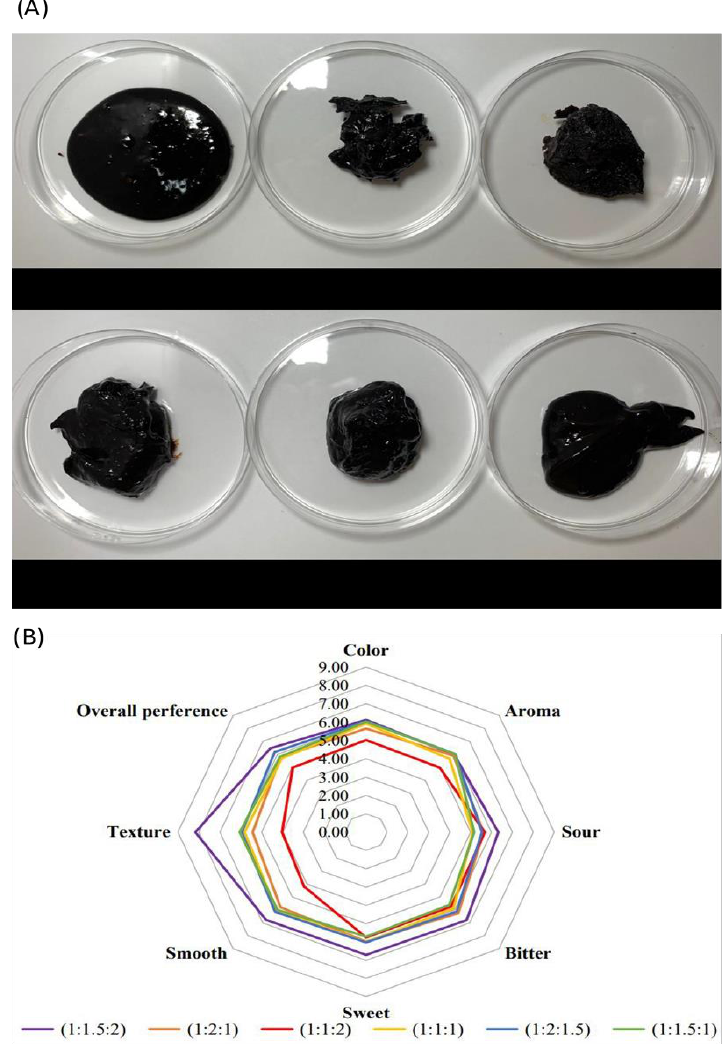
Figure 5. ( A ) The appearance of black garlic jam with different ratios produced by HPP treatment. ( B ) The sensory evaluation of black garlic jam with different ratios by HPP treatment. Six different ratios of garlic/water/sugar ( w/w ) were tested: black garlic/water/sugar ( w/w ) = 1:1.5:2; black garlic/water/sugar ( w/w ) = 1: 2:1; black garlic/water/sugar ( w/w ) = 1: 1:2; black garlic/water/sugar ( w/w ) = 1: 1:1; black garlic/water/sugar ( w/w ) = 1: 2:1.5; and black garlic/water/sugar ( w/w ) =